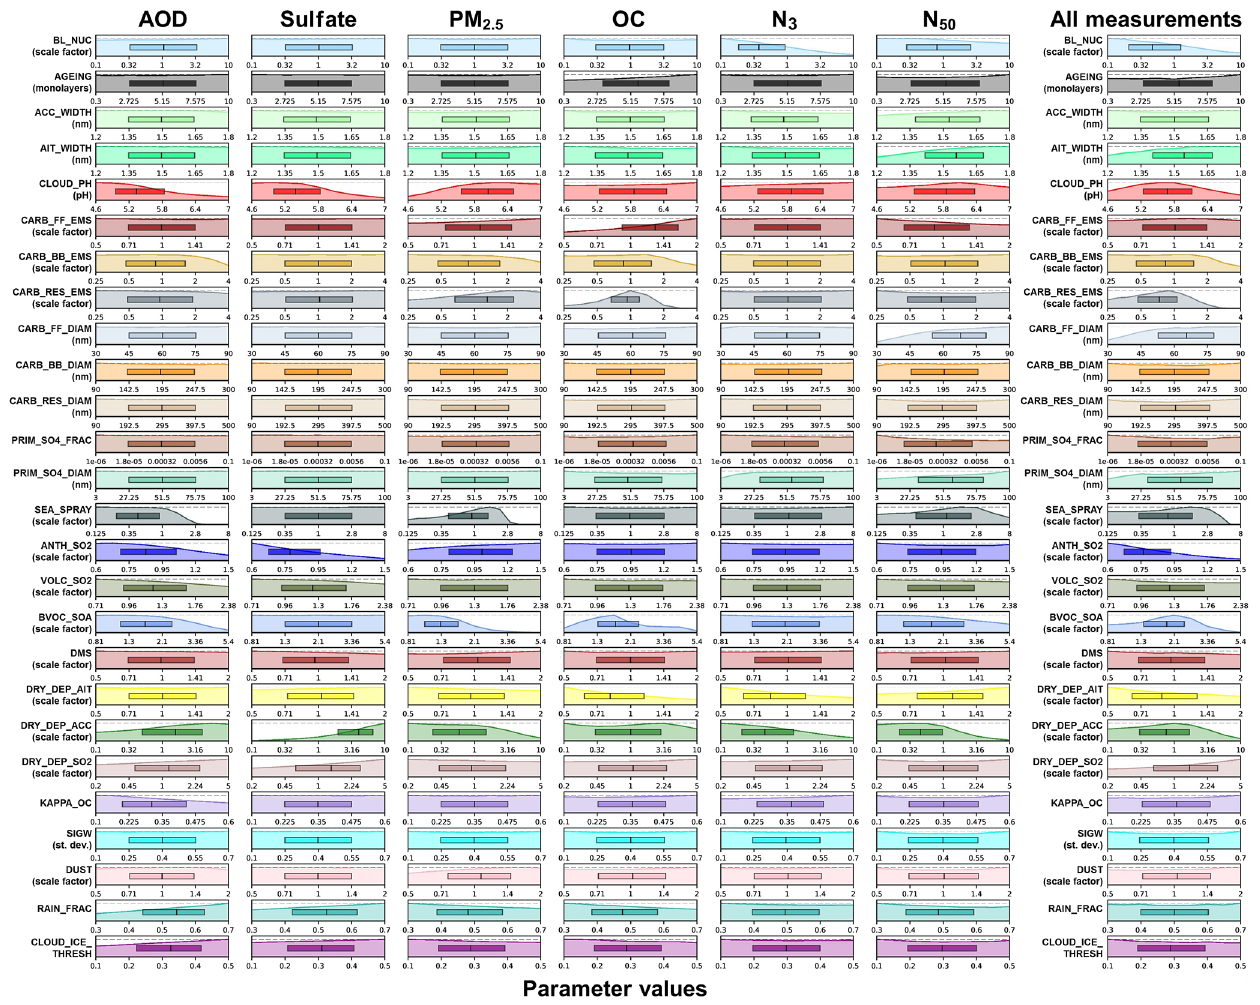
Figure 6. Marginal parameter distributions after constraint using individual measurement types over all months (six columns on the left) and after using all measurement types over all months together (right column). The 25th, 50th and 75th percentiles of each constrained distribution are shown in the central boxes, and the parameter values on the x axes correspond to values as they are used in the model (parameters that are multiplicative scaling factors are shown on the log 10 scale), covering the full parameter ranges (Yoshioka et al., 2019). The corresponding choices of threshold θ and tolerance T that were applied in the constraint process to generate these results are given in Table A2 (left column for each individual measurement type; right column for the joint measurement-type constraint), along with the percentage of model variants that is retained in the constrained sample in each case. See Sect. 2.5 for a definition of marginal parameter